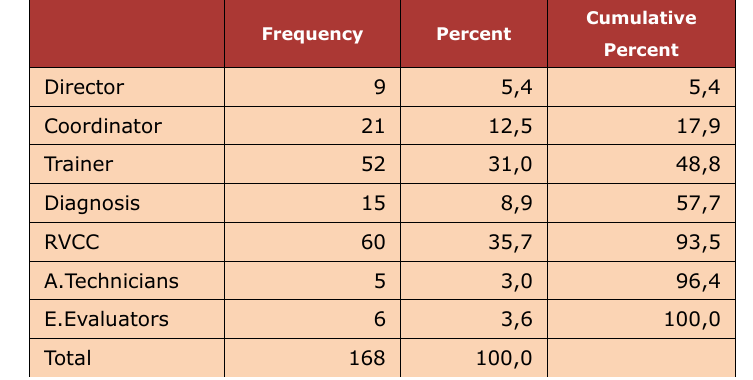
Table 1. NOCs range of occupations, frequencies and